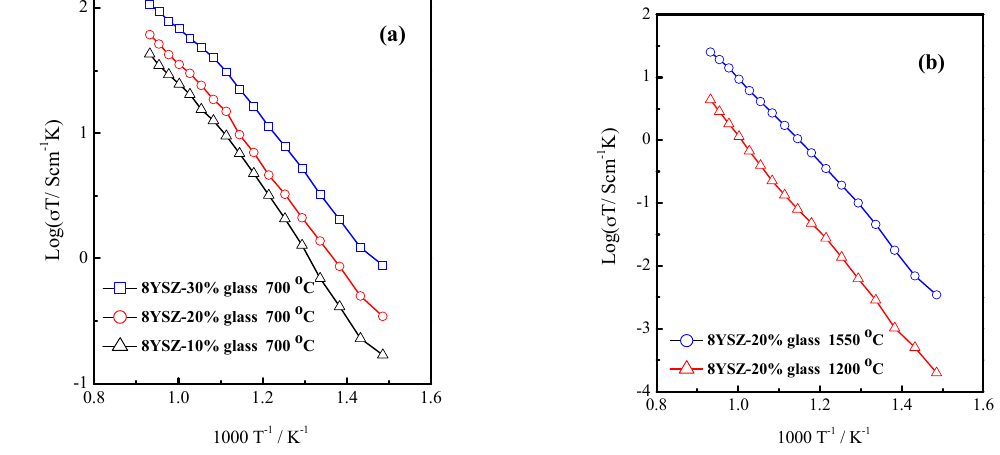
Figure 3. The conductivities vs. ( a ) different weight ratio of the 8YSZ-10% glass, 8YSZ-20% glass and 8YSZ-30% glass after calcined at 700 °C; ( b ) different synthesis temperature of the 8YSZ-20% glass (1200 °C, 1550 °C) in nitrogen atmosphere at 400–800 °C.